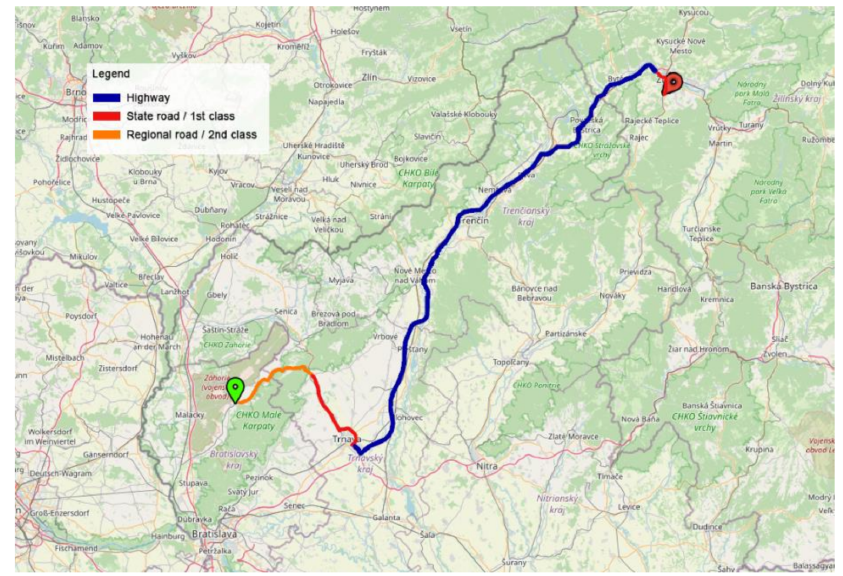
Figure 5. A monitored transport route (map by